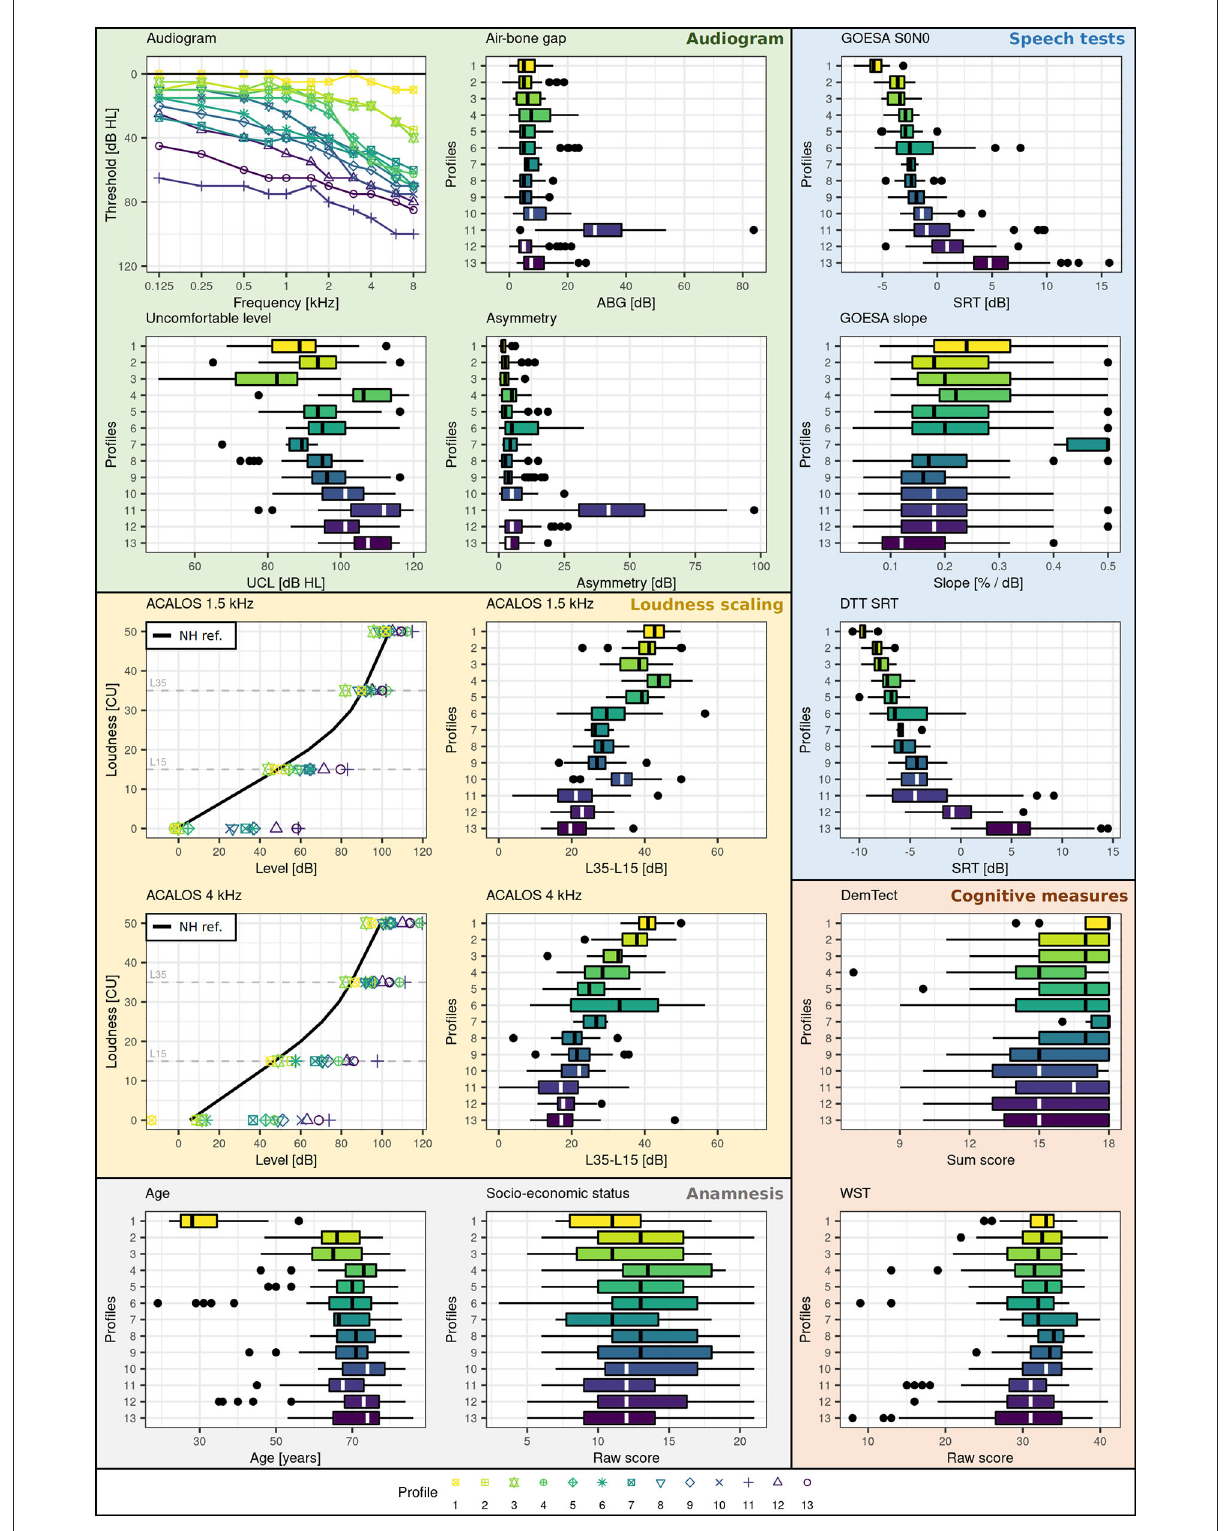
FIGURE3 Profile ranges across measures. Plot backgrounds are colored according to underlying domains. Blue corresponds to the speech domain, green to the audiogram, yellow to the loudness domain, orange to the cognitive domain, and gray to the anamnesis. Profiles are color-coded (yellow to violet) and numbered (1-13) with respect to increasing SRT (impairment) on the